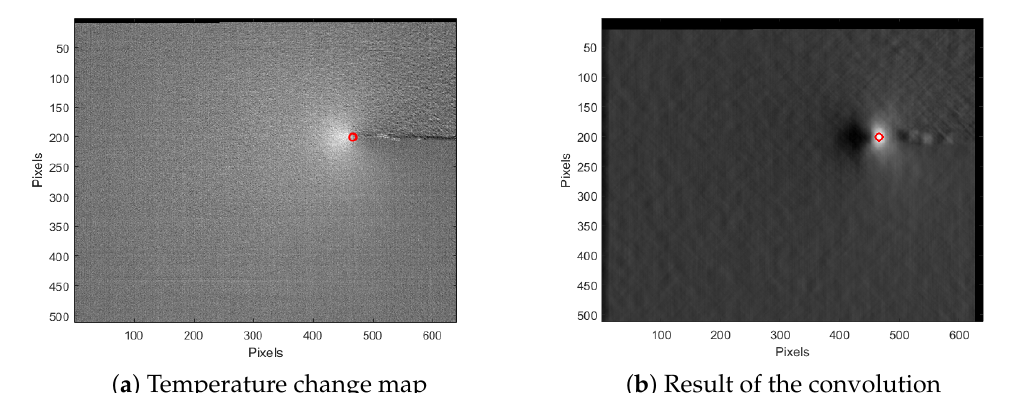
Figure 11. Determination of crack tip position from the image enhanced by the convolution procedure highlighting the crack